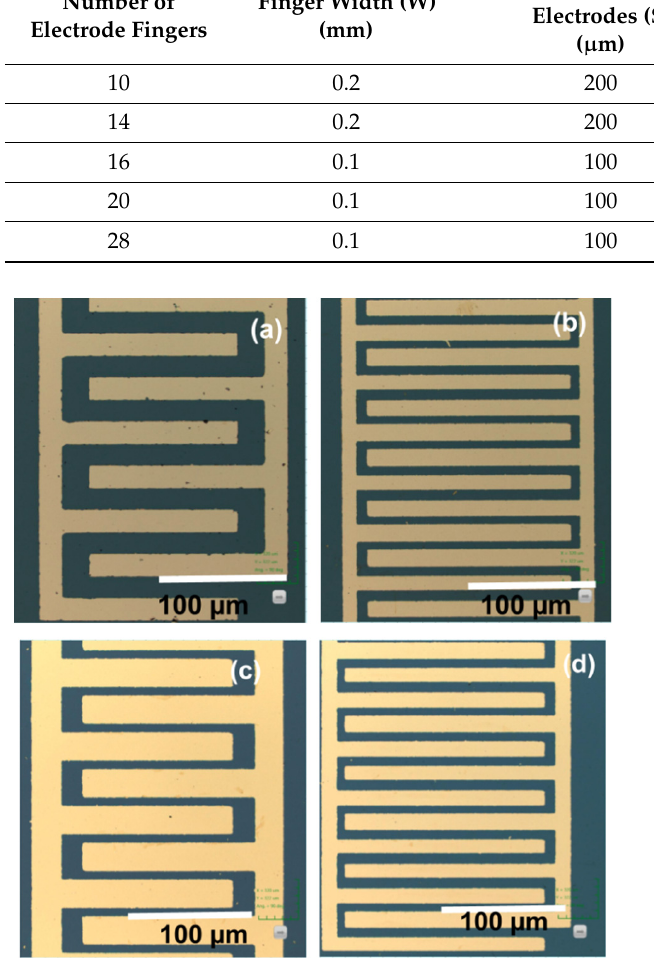
Figure 1. Confocal images of ( a ) 10 fingers and ( b ) 20 fingers by the lift-off method, ( c ) 16 fingers and ( d ) 28 fingers by metal-etching method. Table 1. Comparison of different combinations of ide for same dimension of 6 mm × 3 mm sensor.